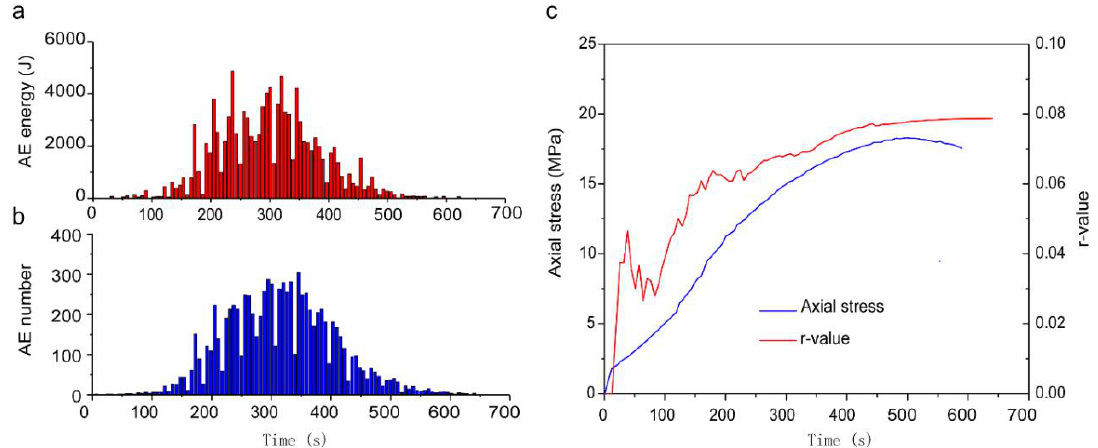
Figure 10. ( a ) Relationship between AE energy and loading time for sample SA-2 under uniaxial compression; ( b ) relationship between AE number and loading time for sample SA-2 under uniaxial compression; ( c ) relationship between axial stress and r -values for sample SA-2 under uniaxial